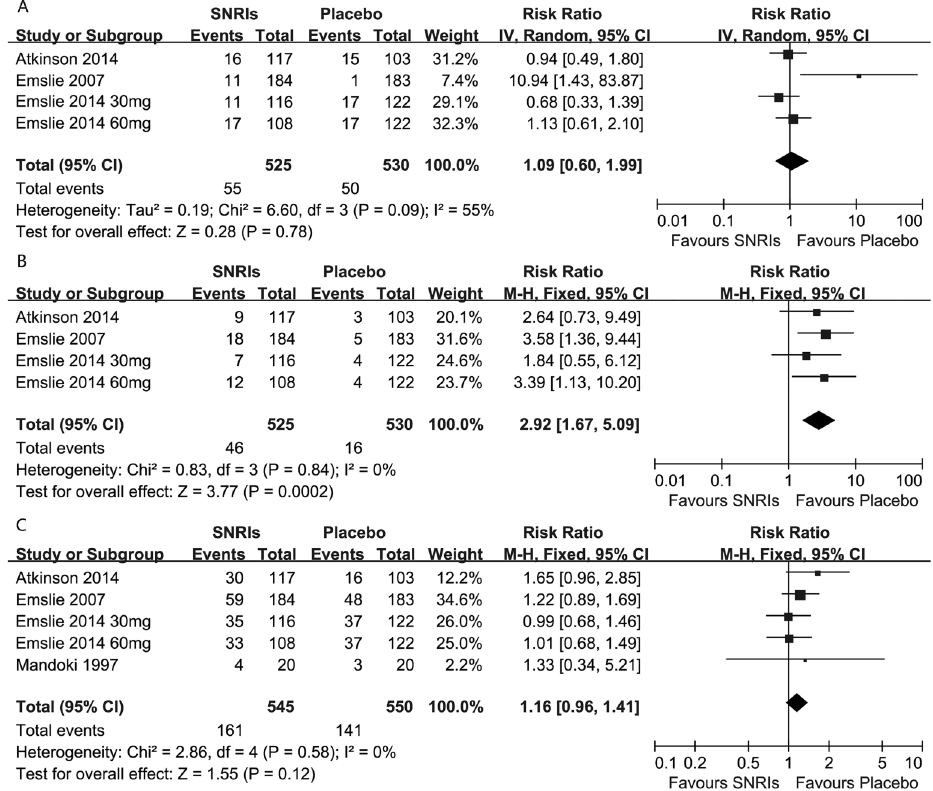
Figure 3. Acceptability outcomes: serotonin-norepinephrine reuptake inhibitor (SNRIs) vs placebo paradigms. A, comparison of SNRIs vs placebo for suicide-related outcome. B, comparison of SNRIs vs placebo for the outcome (patients discontinued treatment due to adverse effects). C, comparison of SNRIs vs placebo for the outcome (patients discontinued treatment due to reasons unrelated to adverse effects). See Table 1 for details of